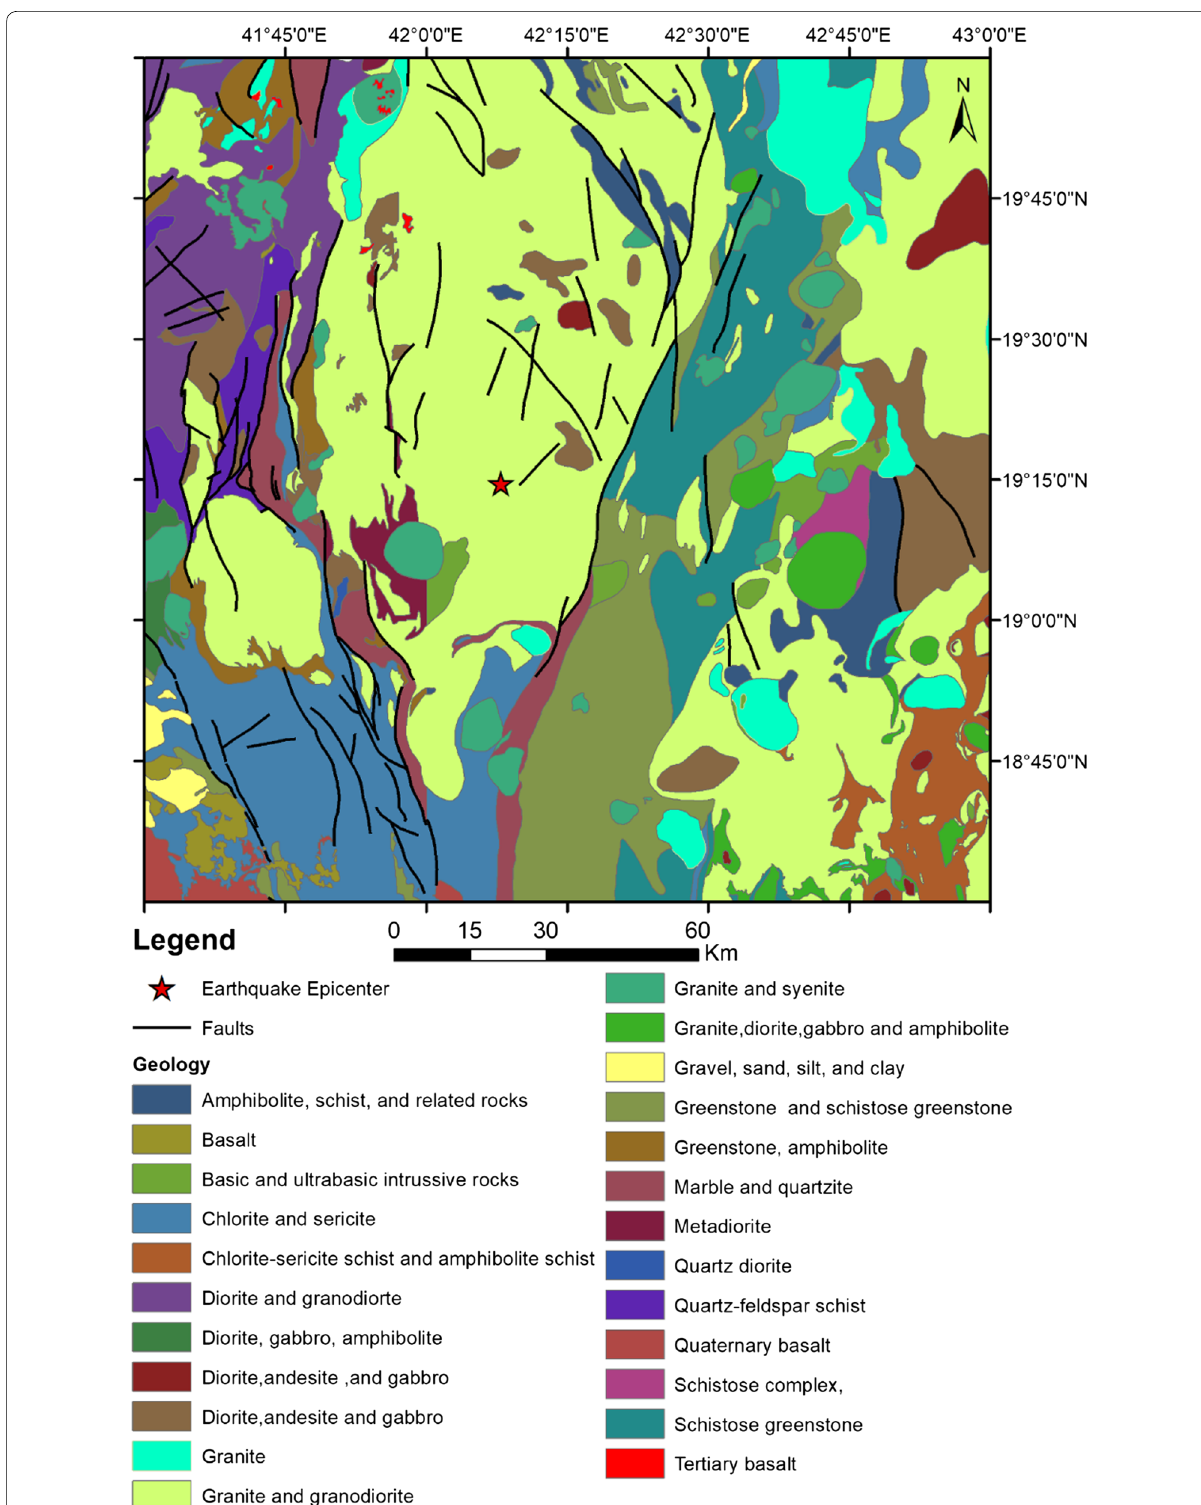
Fig. 2 Geological setting of the study area (modified after Brown and Jackson